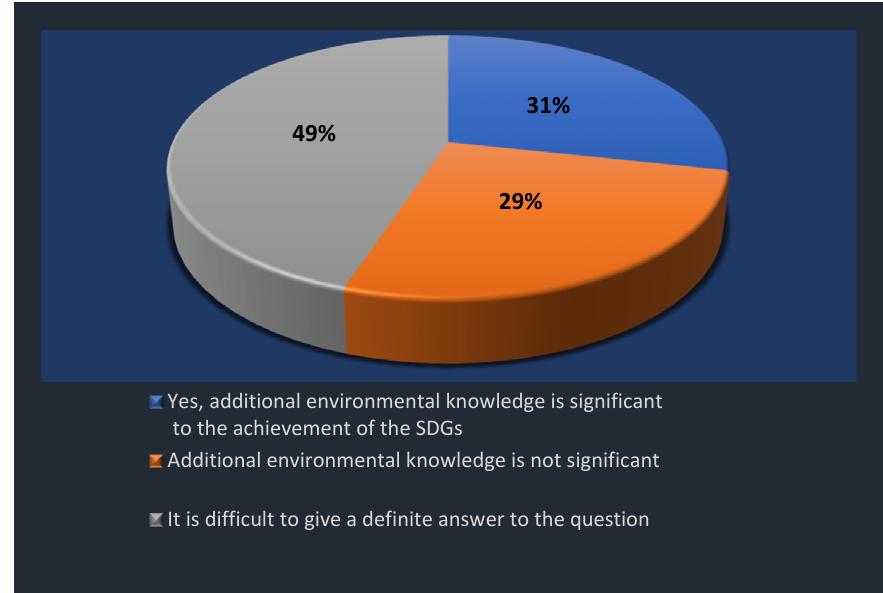
Fig. 2: Do you think that knowing each person’s environment is important to achieving sustainability (regardless of the qualification of the degree)?